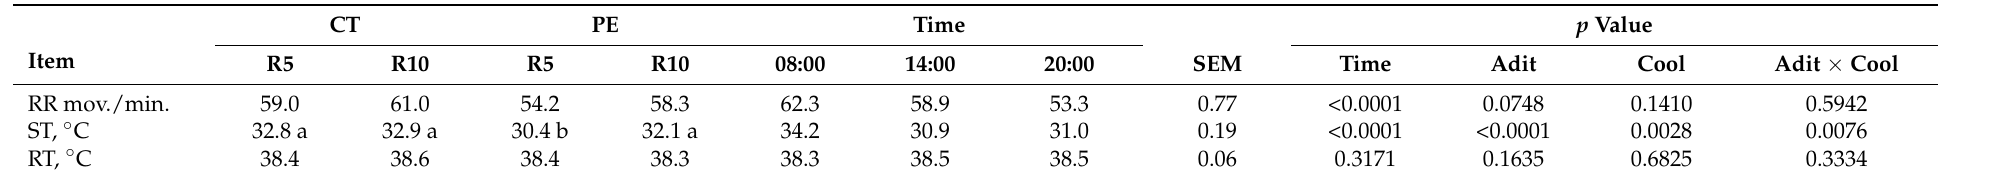
Table 3. Effects of different evaporative cooling regimens and the use or absence of PE on the respiratory rate (RR), surface temperature (ST), and rectal temperature (RT) of lactating Holstein cows ( n =